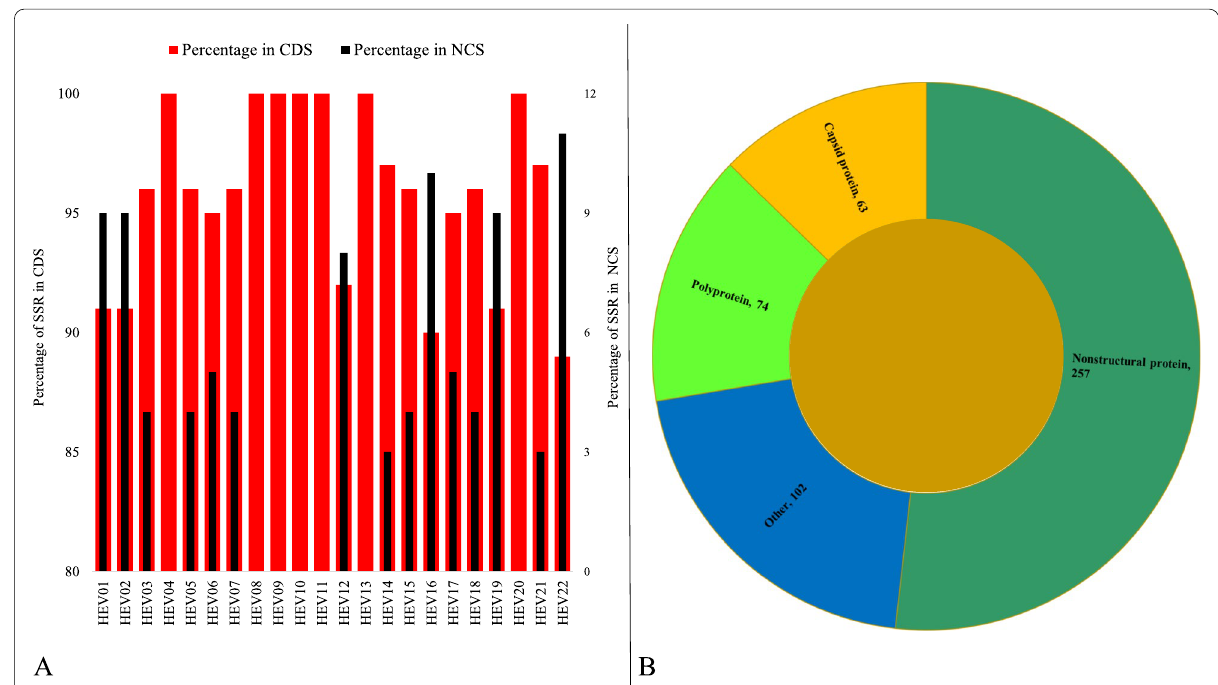
Fig. 4 Distribution of SSRs in Hepeviridae genomes. A Coding and non-coding regions. B Different proteins